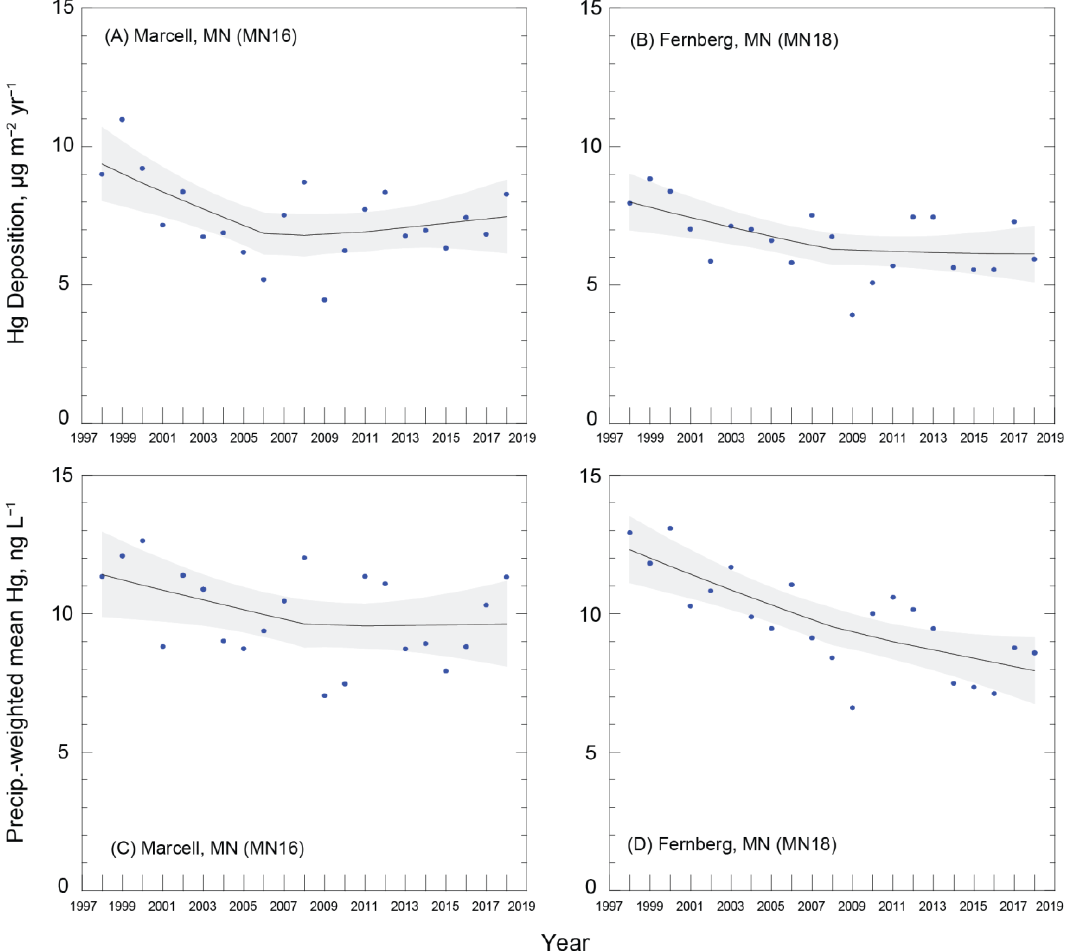
Figure 2. Trend plots of annual wet mercury (Hg) deposition rates for MDN sites MN16 ( A ) and MN18 ( B ); and precipitation-weighted annual mean Hg concentrations for MDN sites MN16 ( C ) and MN18 ( D ) (Trend line is locally weighted regression; shaded region is 95-percent confidence interval. LOESS smoothing parameters are as follows: ( A ) 0.833; ( B ) = 1.0; ( C ) 1.0; and ( D ) 1.0.